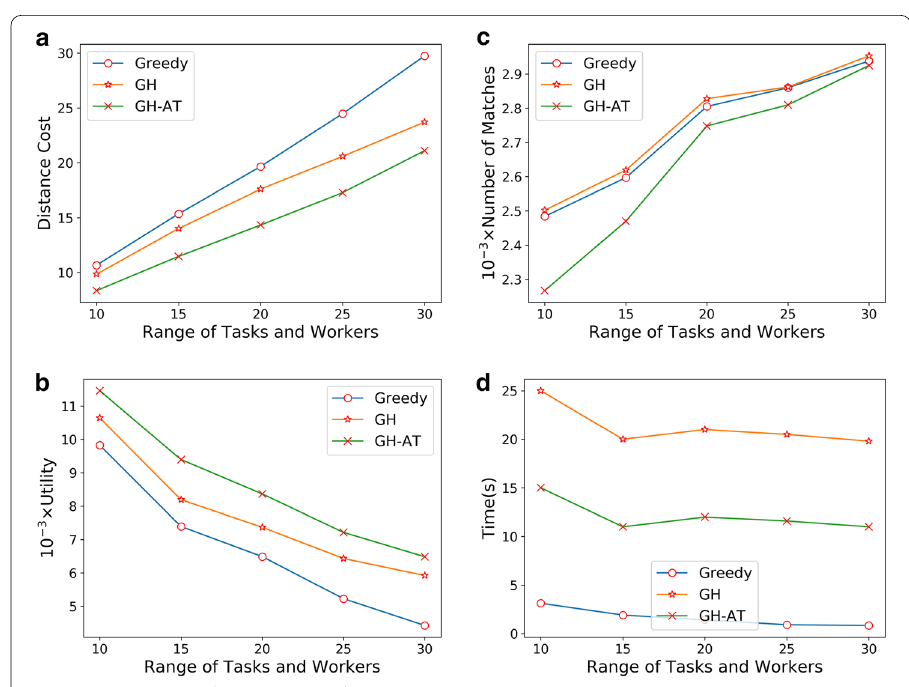
Fig. 8 Experiment results on gMission